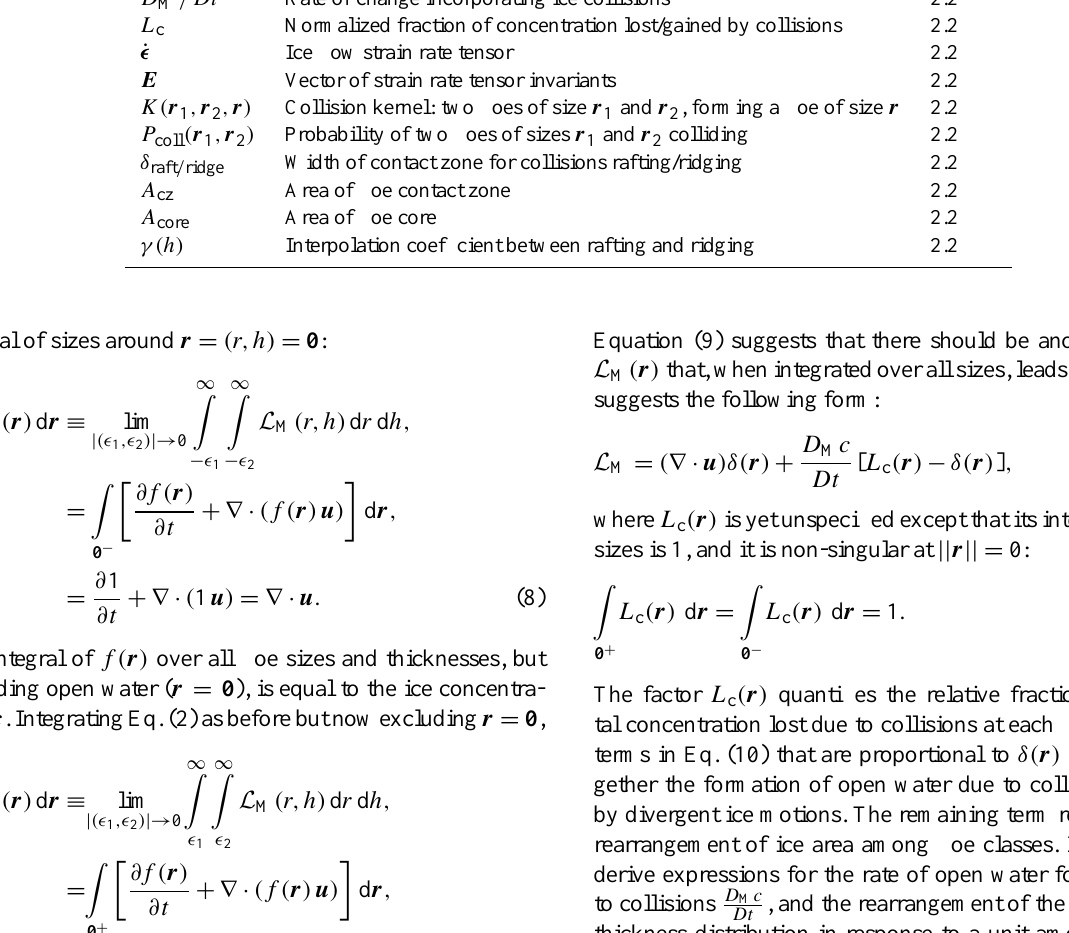
Table 3. Variables used in the representation of mechanical interactions in the FSTD model. Variable Description Section L M Mechanical component of FSTD model 1 D M /Dt Rate of change incorporating ice collisions L c Normalized fraction of concentration lost/gained by collisions Vector of strain rate tensor invariants Collision kernel: two floes of size r 1 and r 2 , forming a floe of size